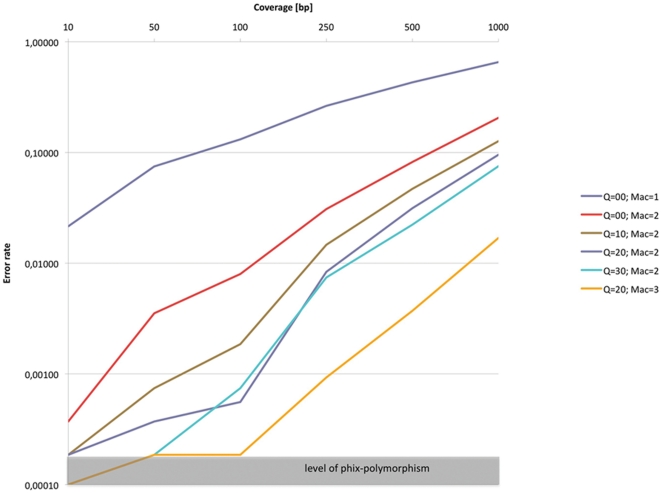
Sequencing errors in relation to coverage, minor allele count, and sequence quality.PhiX sequences (74 bp) generated with an Illumina GAIIx sequencer were analyzed for sequencing error rate (number of mutated bases after quality filtering). The gray bar indicates the presence of a polymorphic site in the PhiX sequence, which results in a minimum sequencing error rate.